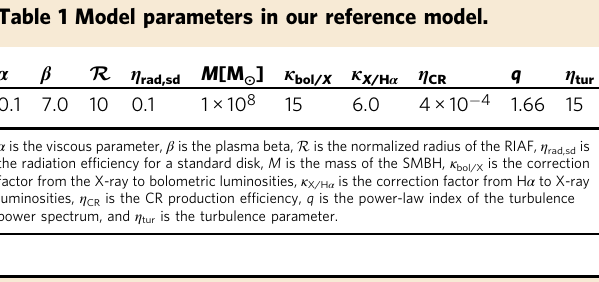
Table 2 Resulting quantities for various _ m in our